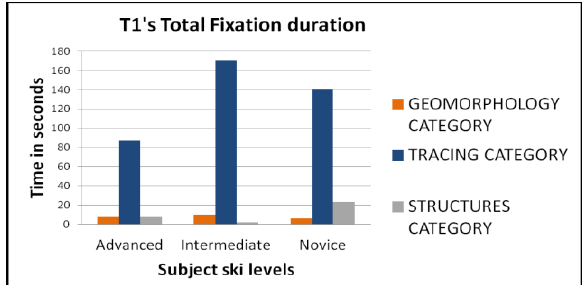
Figure 7 Total fixation count for graphic objects gazed during the visual exploration of the ski map (T1)